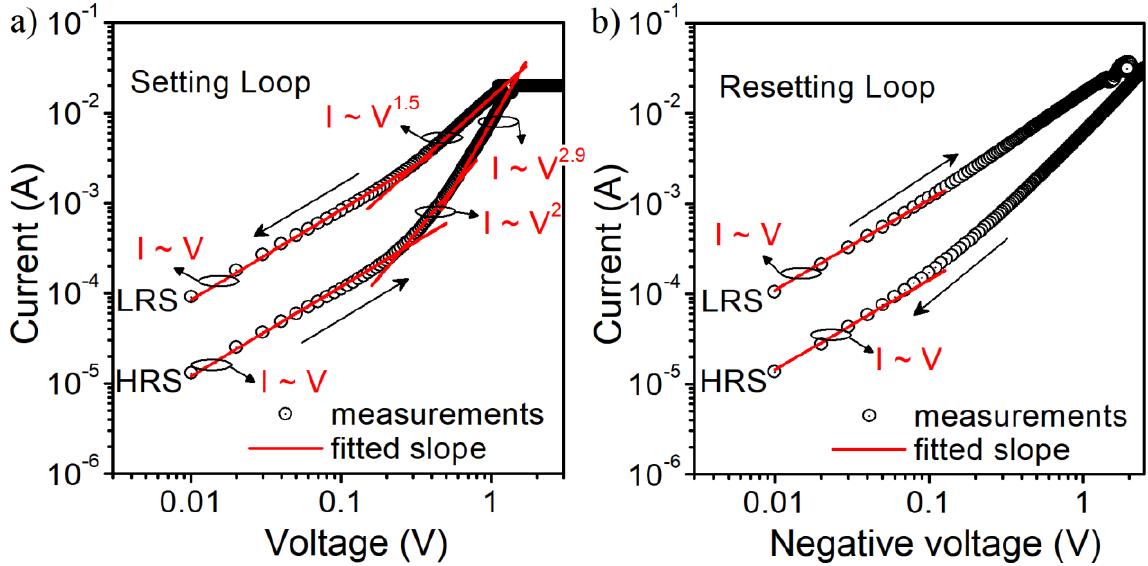
Figure 4. Current-voltage characteristics of Al/SiO 2 /n ++ Si RRAM structure S1 with the gate diameter of 156 μm and CC = 20 mA at SET ( a ) and RESET ( b ) cycle with fitted curves of different slopes.